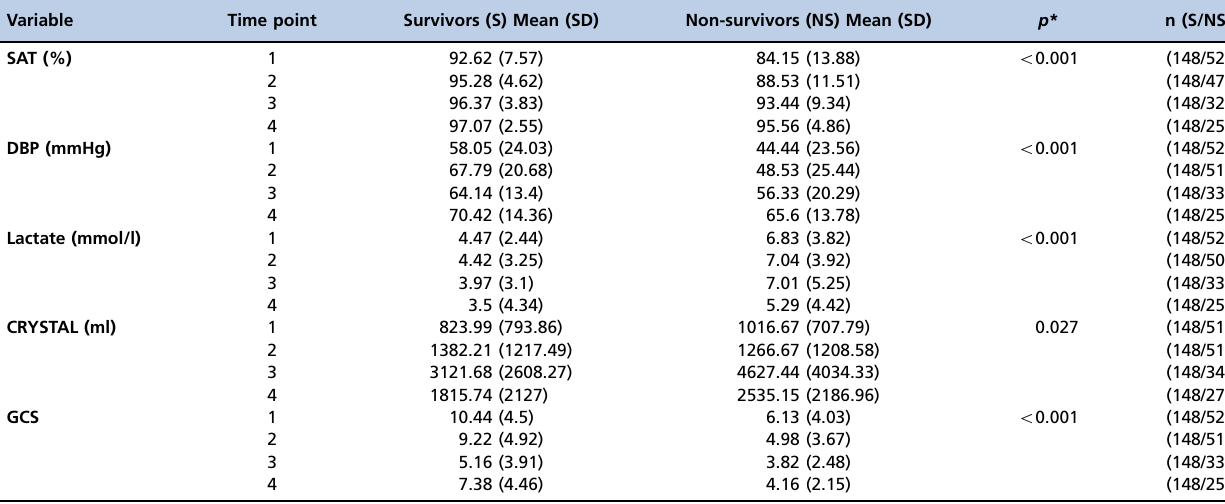
Table 3 - Comparison of quantitative variables (significant for death in GEE) between the survivor and non-survivor groups at the time points of standard collection (significant for death at GEE model). Variable Time point Survivors (S) Mean